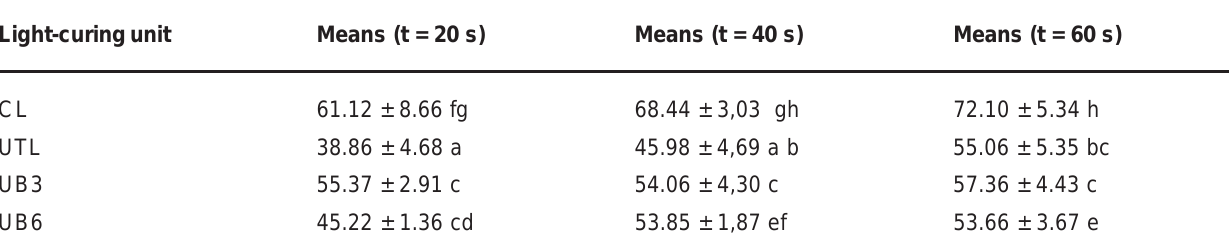
TABLE 2- Composite resin microhardness means (KHN) and standard deviation Light-curing unit